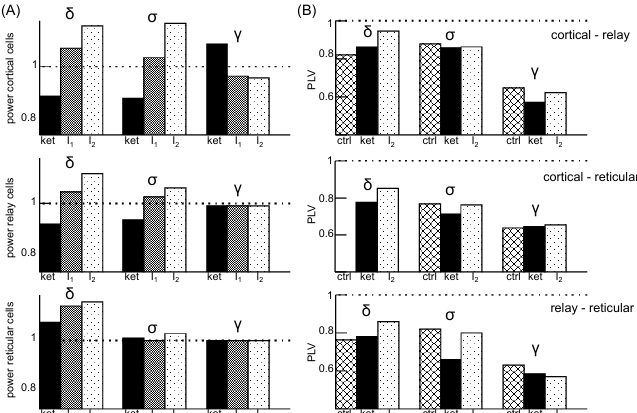
Figure 7. Relative spectral power and phase coherence PLV in the cortico-thalamic circuit. ( A ) The ratio of power spectral density averaged over frequencies in the corresponding frequency band and the corresponding average power spectral density in the control condition. The power in cortical cells consider GIG cells. ( B ) Degree of phase coherence (PLV) between excitatory cortical GIG population activity and the excitatory relay population activity (top panel), the excitatory cortical GIG layer and the reticular population activity (center panel) and between the reticular and relay cells (bottom panel). Note that there is no cortico-reticular δ − phase coherence in the control condition. Model = 2.0, f = 1.03 and f = 1.05 for stimulation input I > I parameters are f resp 1 and I 2 1 , tDCS tDCS tDCS respectively. Ketamine parameters are identical to parameters used in Figure